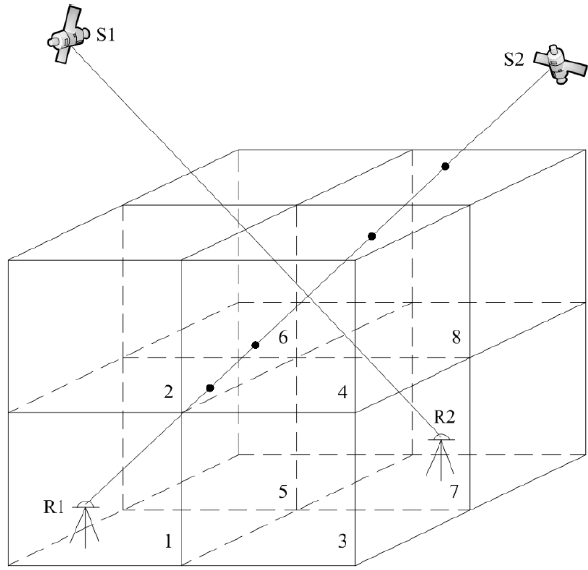
Figure 3. Schematic representation of 3-D water vapor